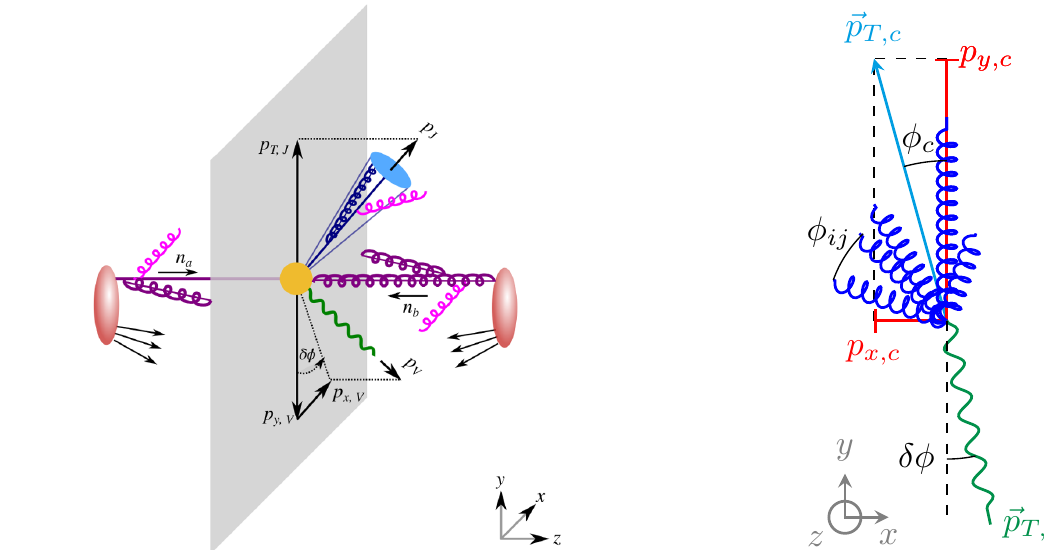
Figure 1. Left: The azimuthal angle between the vector boson (green) and jet axis (blue) is related to the momentum of the vector boson p x,V transverse to the colliding protons (red) and jet. Collinear initial (purple) and final-state (blue) radiation and soft radiation (magenta) is also shown. Right: Schematic of the transverse plane: the angle φ c between WTA axis (along y axis) and collective collinear momentum, the angle φ ij between two generic collinear emissions i and j , and the angular decorrelation observable δφ . These quantities are of the same parametric